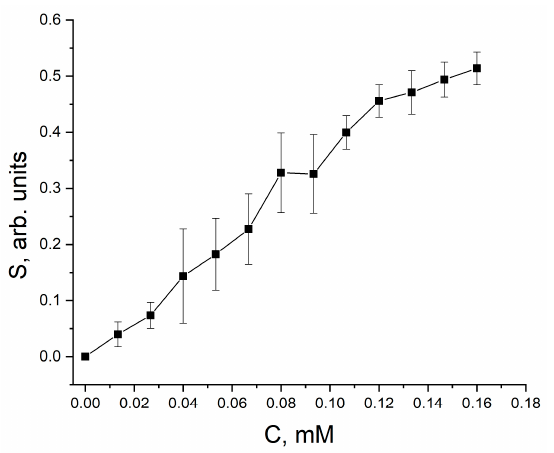
Figure 3. Calibration curve of sensor response vs. glucose concentration.